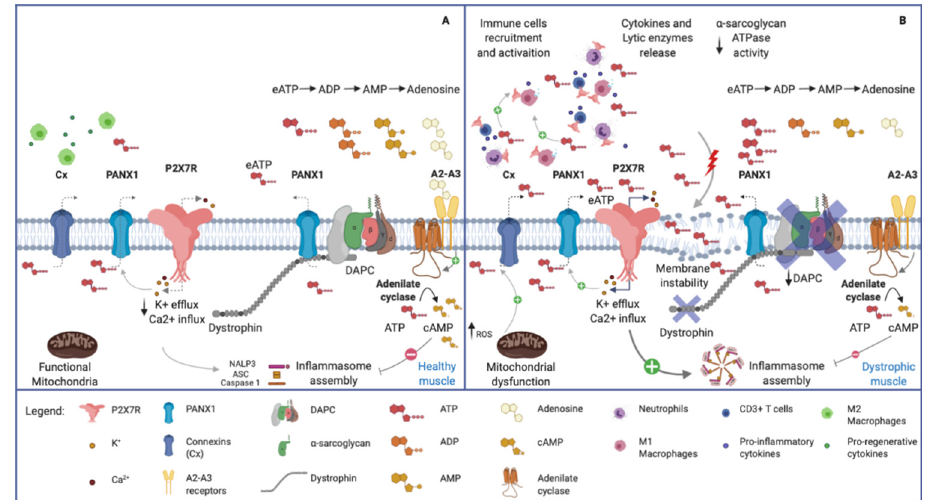
Figure 3. Purinergic signal in normal and dystrophic muscles. ( A ) Healthy skeletal muscle. Note the plasma membrane’s integrity, the normal expression of Dystrophin Associated Protein Complex (DAPC) and the physiological low concentration of eATP. ( B ) Dystrophic skeletal muscle. The membrane instability, due to DAPC alteration, induces chronic release of ATP in the extracellular space, and recalls pro-inflammatory immune cells (i.e., neutrophils, M1 macrophages and CD3 + Tcells). eATP, in turn, activates P2X7R receptors on muscular and immune cells, leading to pro-inflammatory citokines release via NLRP3 inflammasome activation. Connexin and Pannexin hemichannels contribute to the release of ATP, being activated respectively by increased ROS production and P2X7R-mediated K + efflux. The high eATP concentration in dystrophic tissue is influenced by the reduced ectoATPase activity mediated by the α -sarcoglycan. Adenosine, acting via A2–A3 receptors, stimulates adenilate cyclase which produces cAMP. The latter compound activates the phosphorylation of NLRP3 reducing its oligomerization and increasing its ubiquitination to be degraded in autophagosomes.